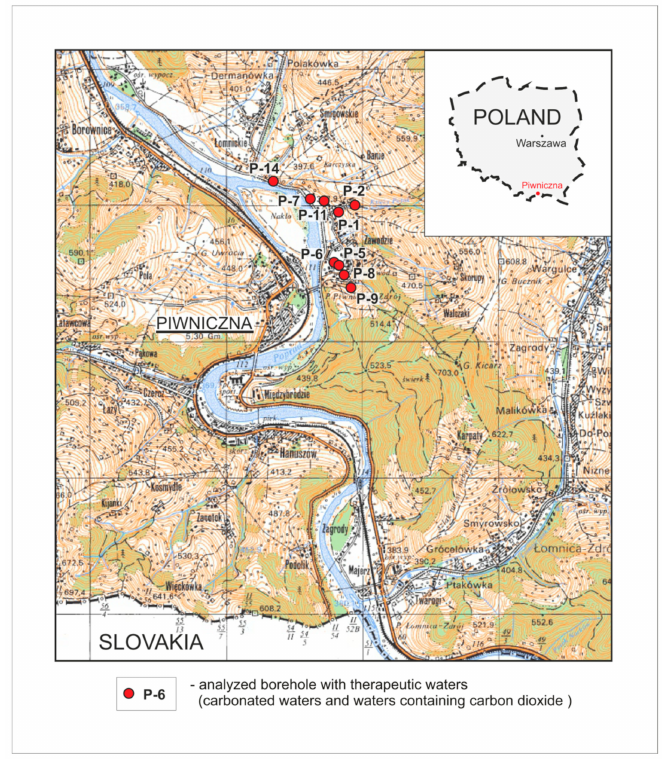
Figure 2. Location of analyzed